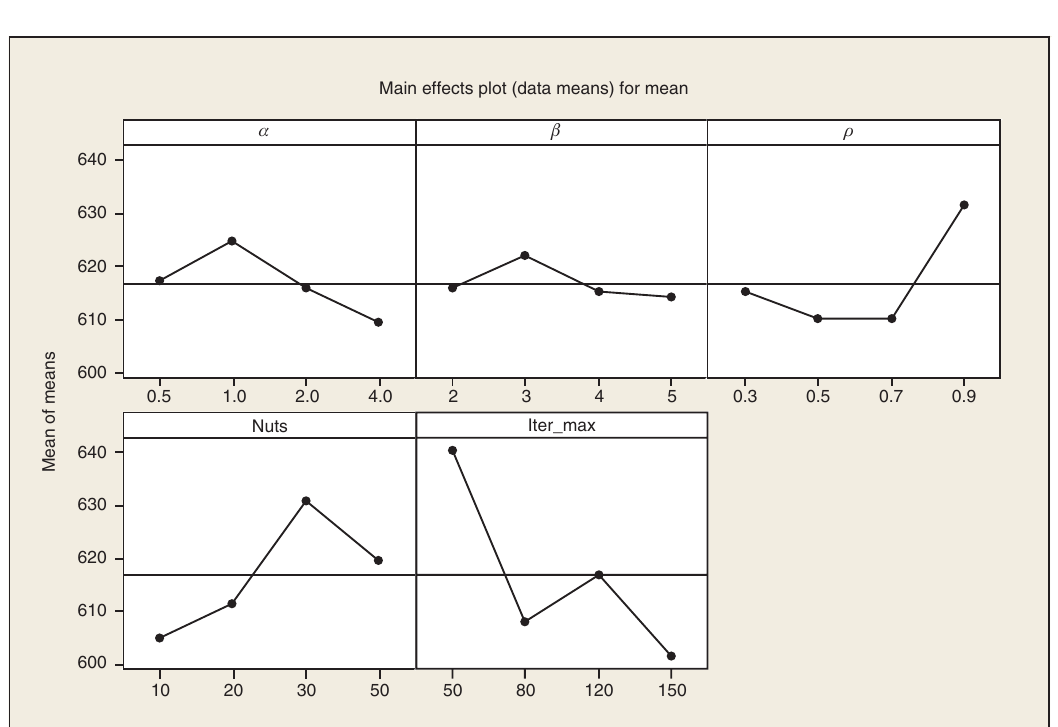
Figure 5: Main Effects Plot for Means.